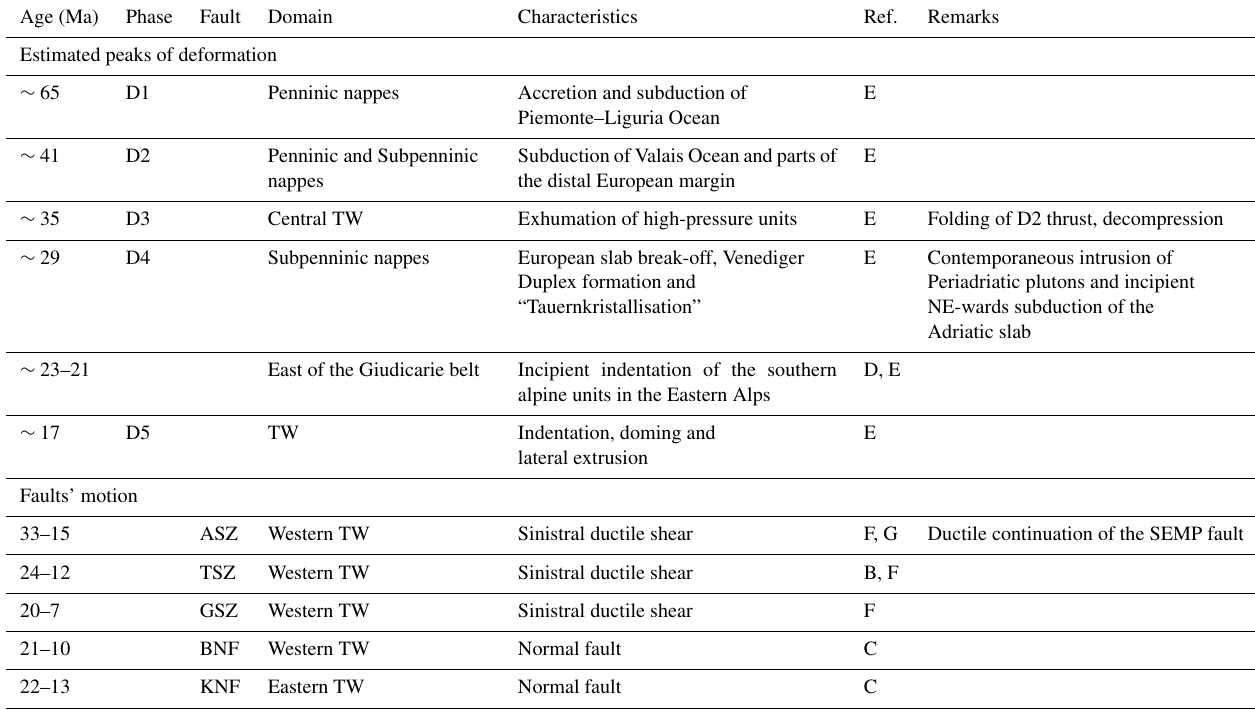
Table 2. Summary of deformation phases in the Tauern metamorphic dome. Domain Characteristics